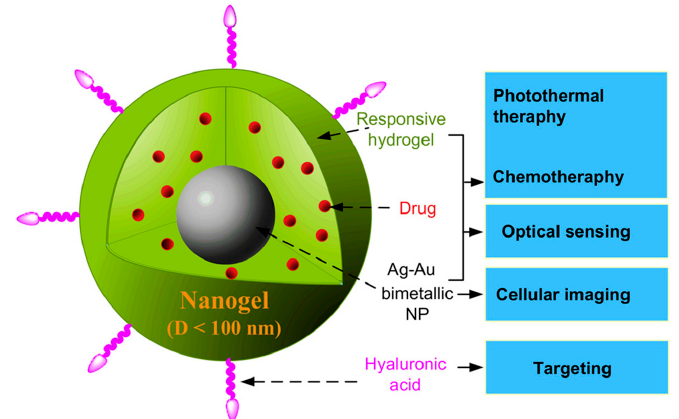
Figure 4. Schematic picture of multi-functional hybrid nanogel (NG) containing a bimetallic Ag-Au core coated with poly(ethylene glycol) (PEG) network and surface-decorated with hyaluronic acid (HA) molecules as targeting ligands. (Reprinted with permission from reference [76]. Copyright 2010 ACS).